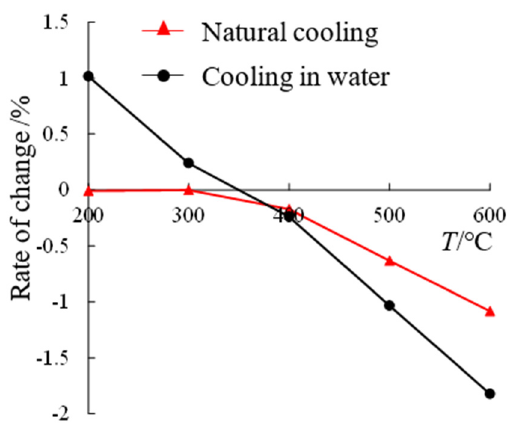
Figure 5. Volume change under different cooling